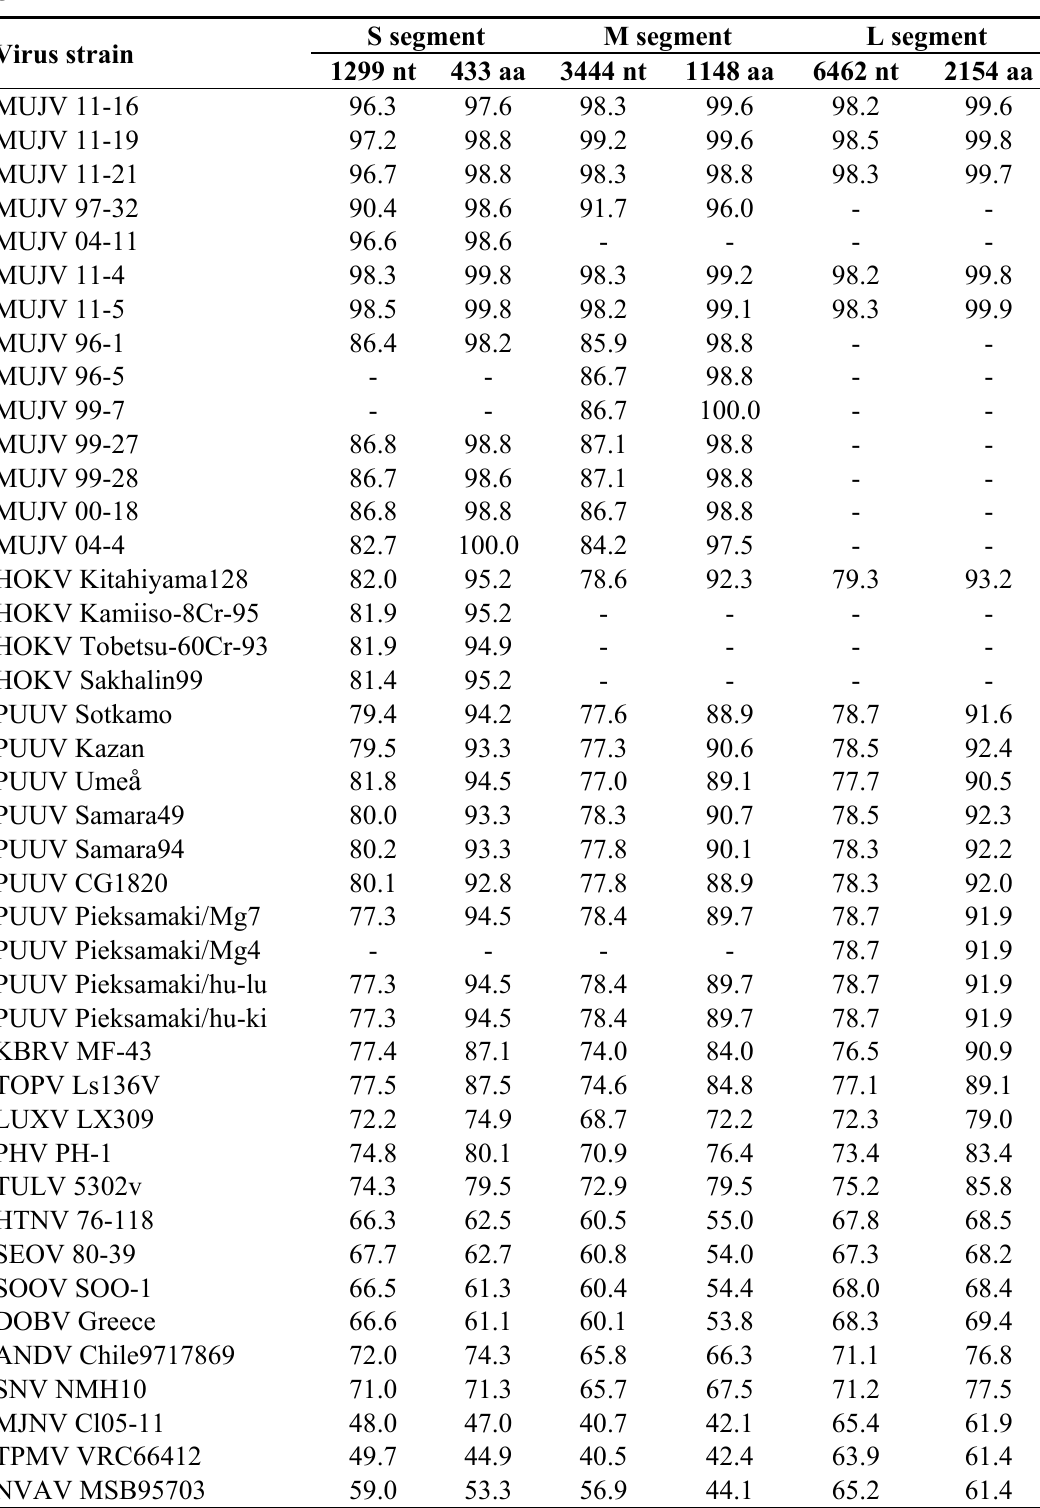
Table 2. Nucleotide and amino acid sequence similarities (%) of the full-length S, M and L segments of MUJV strain 11-1 and other